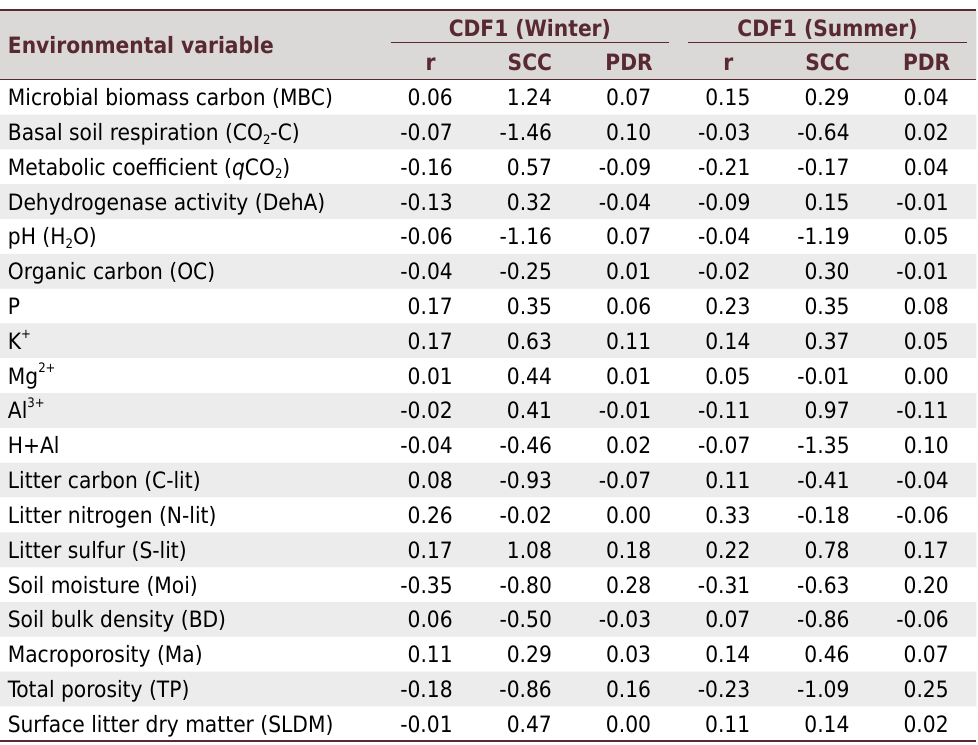
Table 1. Standardized canonical coefficients (SCC), canonical correlation (r), and Parallel Discrimination Rate (PDR: r × SCC) related to canonical discriminant analysis (CDA) containing environmental variables, in winter and summer, regardless of the